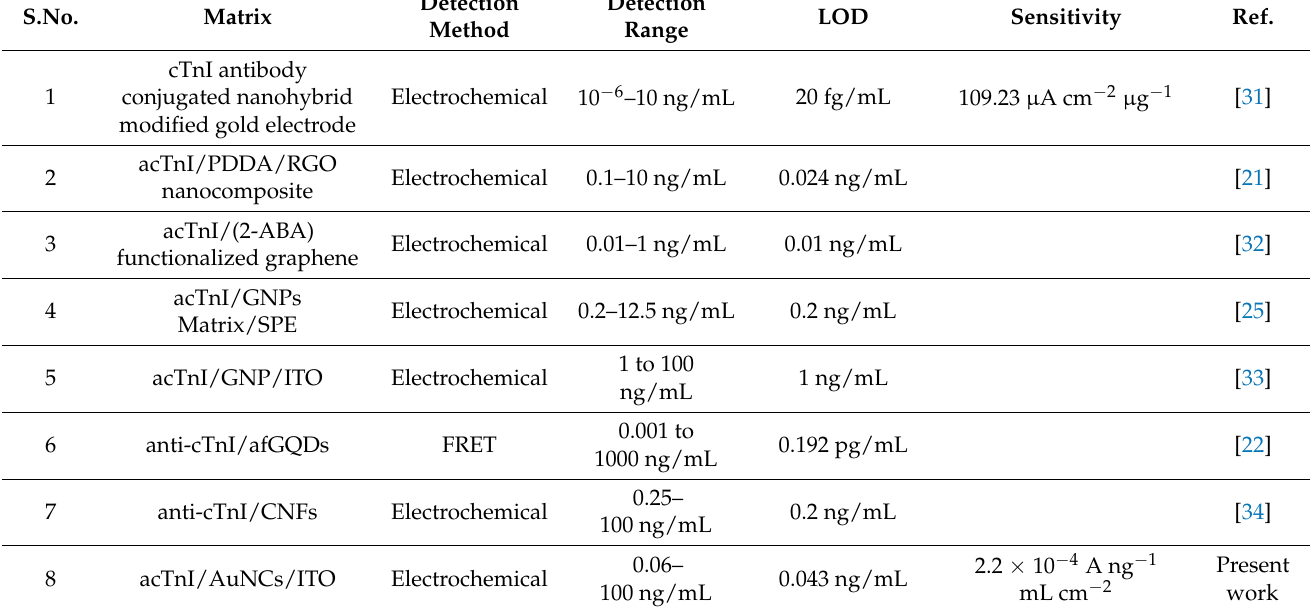
Figure 6. ( a ) Cyclic voltametric response of fabricated immunosensor (at concentration 0.06–1 ng/mL) Inset: Calibration between the magnitude of anodic peak current (mA) and concentration (ng/mL) ( b ) Cyclic voltametric response of fabricated immunosensor (at concentration 1–100 ng/mL) Inset: Calibration between the magnitude of anodic peak current (mA) and concentration (ng/mL), ( c ) shelf-life study of the AuNCs/APTMS/ITO and ( d ) BSA/acTnI/Cys/AuNCs/ITO immunoelec- trode for a period of 30 days. Table 1. Comparison of developed immunosensor with the available methods in the 10 −4 A ng −1 mL cm −2 and limit of detection: 0.043 ng/mL. With the help of a Line weaver– Burke plot, the average association constant ( Ka ) was calculated as 3.025 × 10 −2 M. The Ka